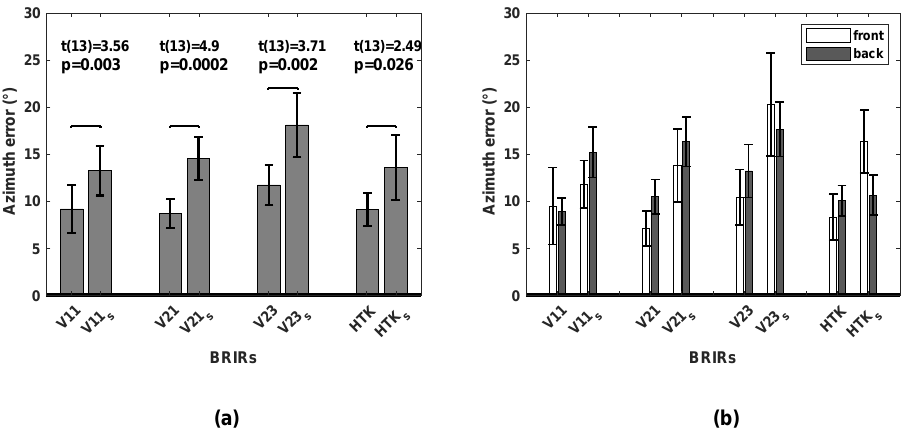
Figure 11. ( a ) Azimuth error, averaged over 14 subjects and all target sources when localizing virtual sources generated with V11, V21, V23 and HTK in TestDynamic and with V11 s , V21 s , V23 s and HTK s in TestStatic. Horizontal bars indicate significant differences (according to paired t -test). ( b ) Azimuth error in TestDynamic and TestStatic, averaged over 14 subjects for target sources grouped into front and back. All error bars indicate 95% confidence intervals.